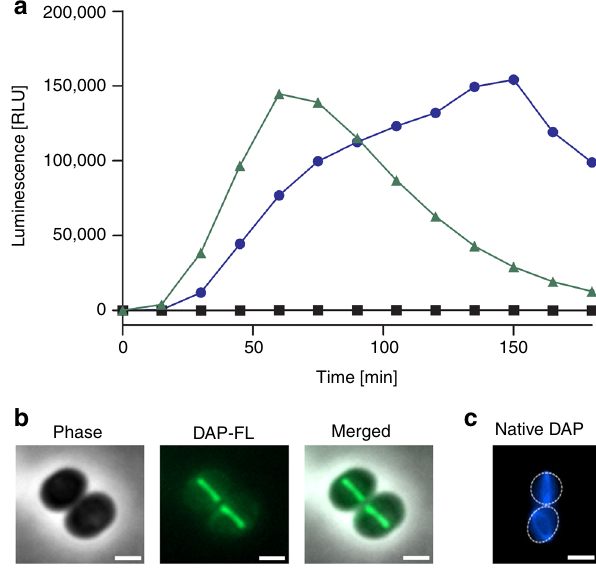
Fig. 1 DAP speci fi cally induces the LiaRS stress response in the presence of Ca 2 + and binds to the cell division site. a P liaI - lux induction in B. subtilis was monitored upon addition of DAP (0.5 µ gml − 1 ) in the absence (black line) or presence (blue line) of 1.25mM Ca 2 + and teixobactin (0.5 µ gml − 1 ) (green line). Luciferase activity is presented as relative luminescence units (RLU). Representative graph of three independent experiments. b , c DAP localises to the septum of S. aureus . Cells were grown to mid-exponential phase (OD 600 = 0.5) followed by the addition of Ca 2 + and a mixture of labelled and unlabelled DAP (7 µ gml − 1 DAP; 0.8 µ gml − 1 DAP-FL) b or unlabelled DAP (7 µ gml − 1 ) c . Cells were washed and imaged by fl uorescence microscopy; phase, phase contrast. Cell outlines in c are indicated by dashed lines. Scale bar: 1 µ m. Representative images from fi ve independent experiments are shown. Source data are provided as a Source Data fi le.